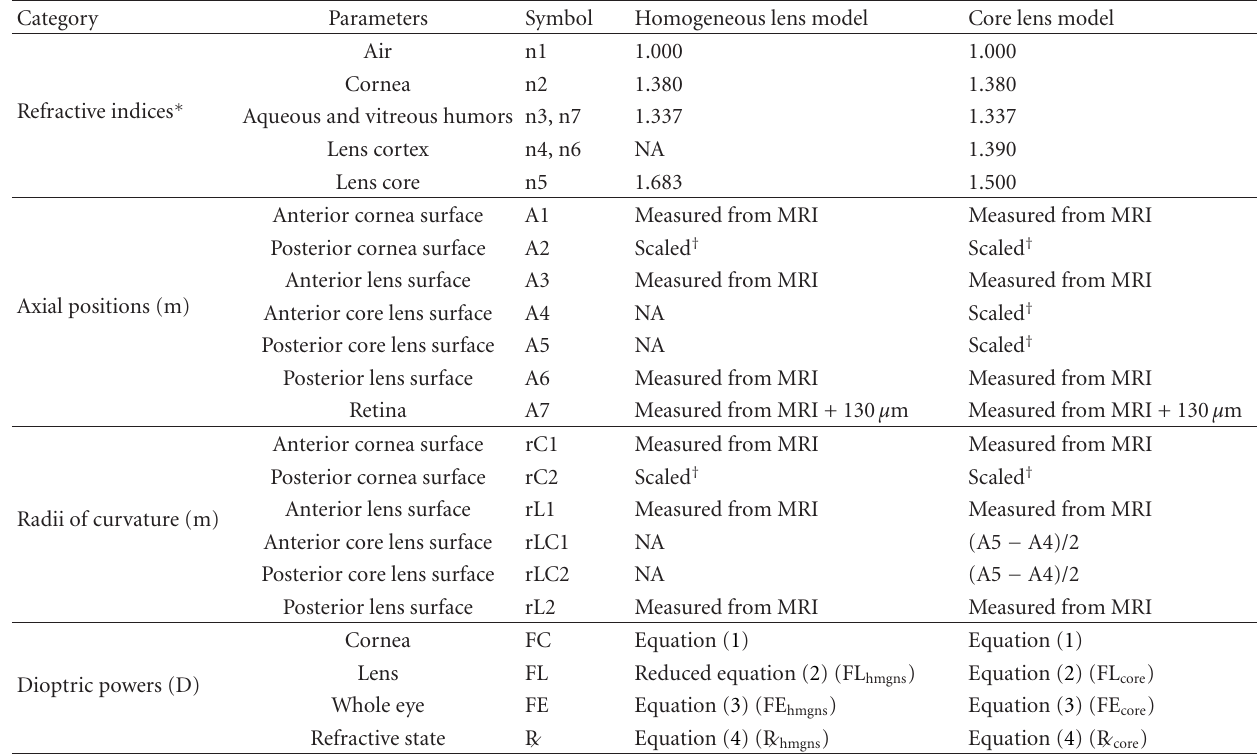
Table 1: Parameters for refractive state estimation in rat